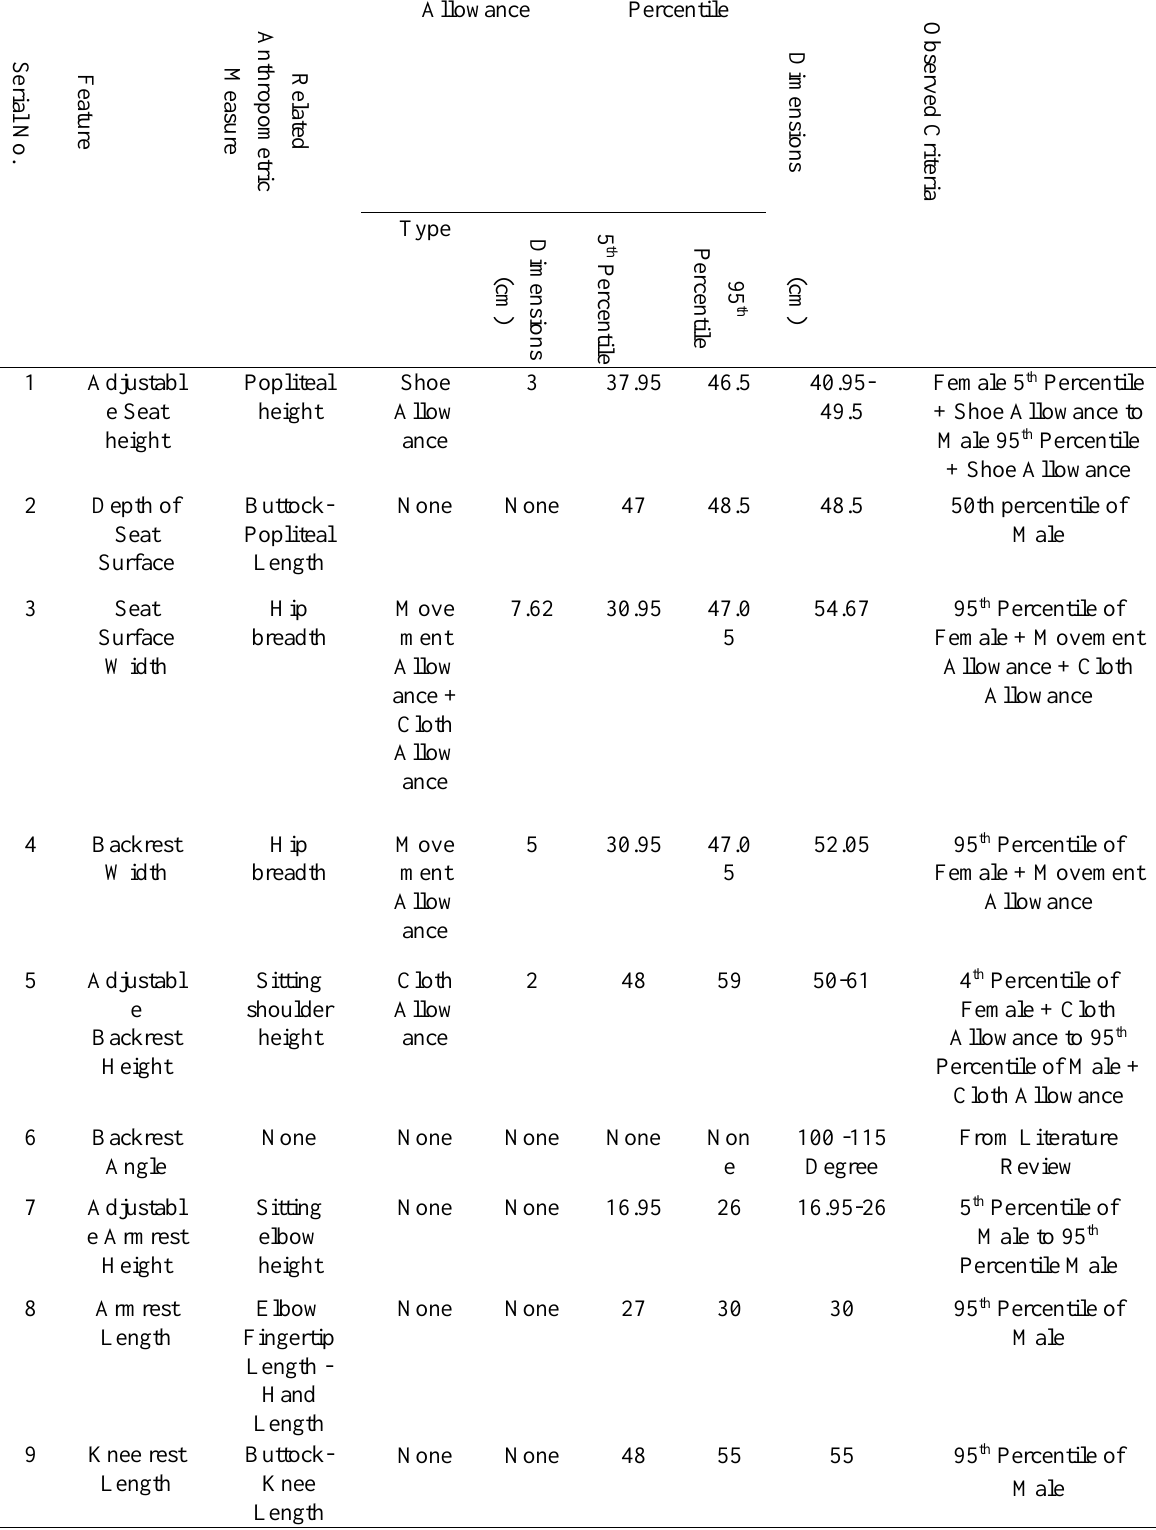
Table 4. Recommended specification for the multi-featured ergonomic office